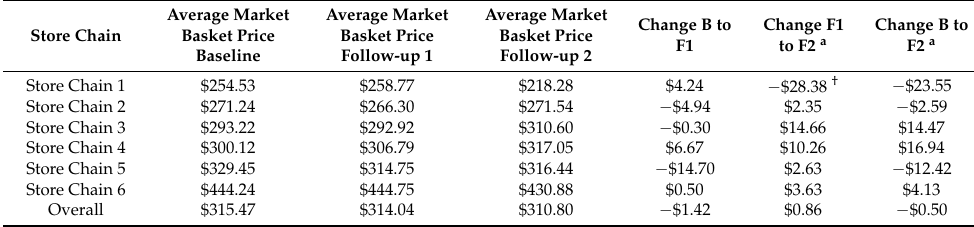
Table 2. Comparison of total market basket cost, by time store chain, averaged across locations, at baseline, follow-up 1, and follow-up